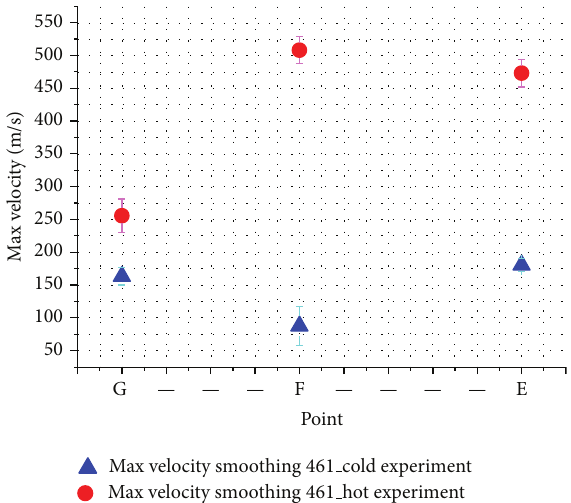
Figure 21: Velocity trend measured by 461, 100Pa 500 Pa/s hot experiment point P.